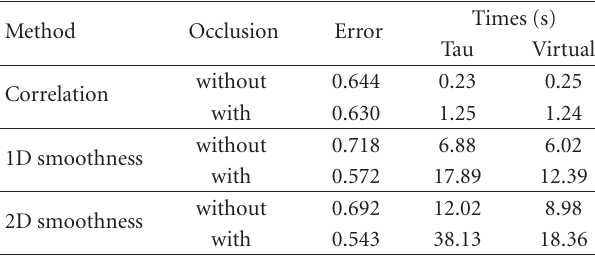
Figure 5: A photography shot at Palais du Tau (a) and a virtual scene (b). Table 1: Errors with ground truth on the virtual scene plus computation times on both Palais du Tau and virtual sets.